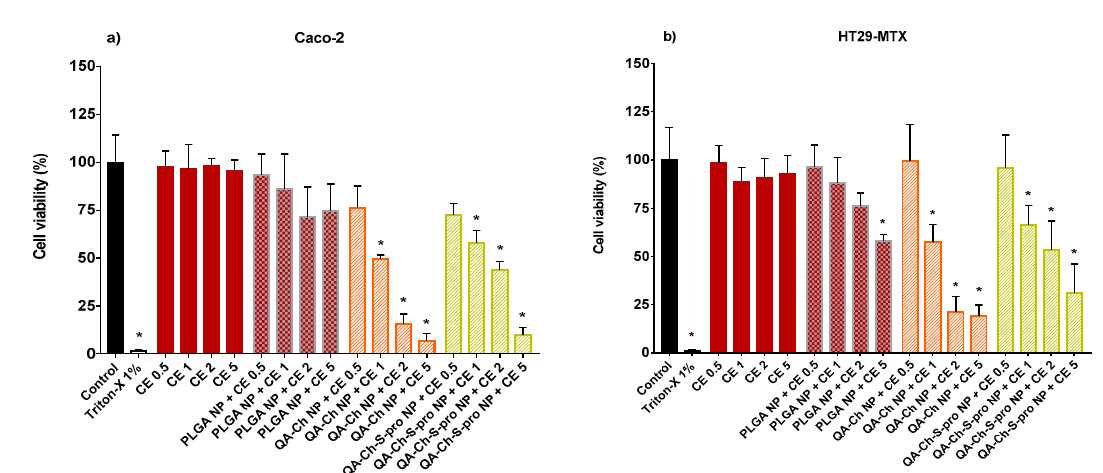
Figure 3. Caco-2 ( a ) and HT29-MTX ( b ) cell viability after 24-h treatment with CE free or loaded in different types of NPs at the polyphenol concentrations of 0.5, 1, 2, and 5 µg/mL gallic acid equivalent (GAE). Triton-X 1% was used as a negative control. *, significantly different from control.